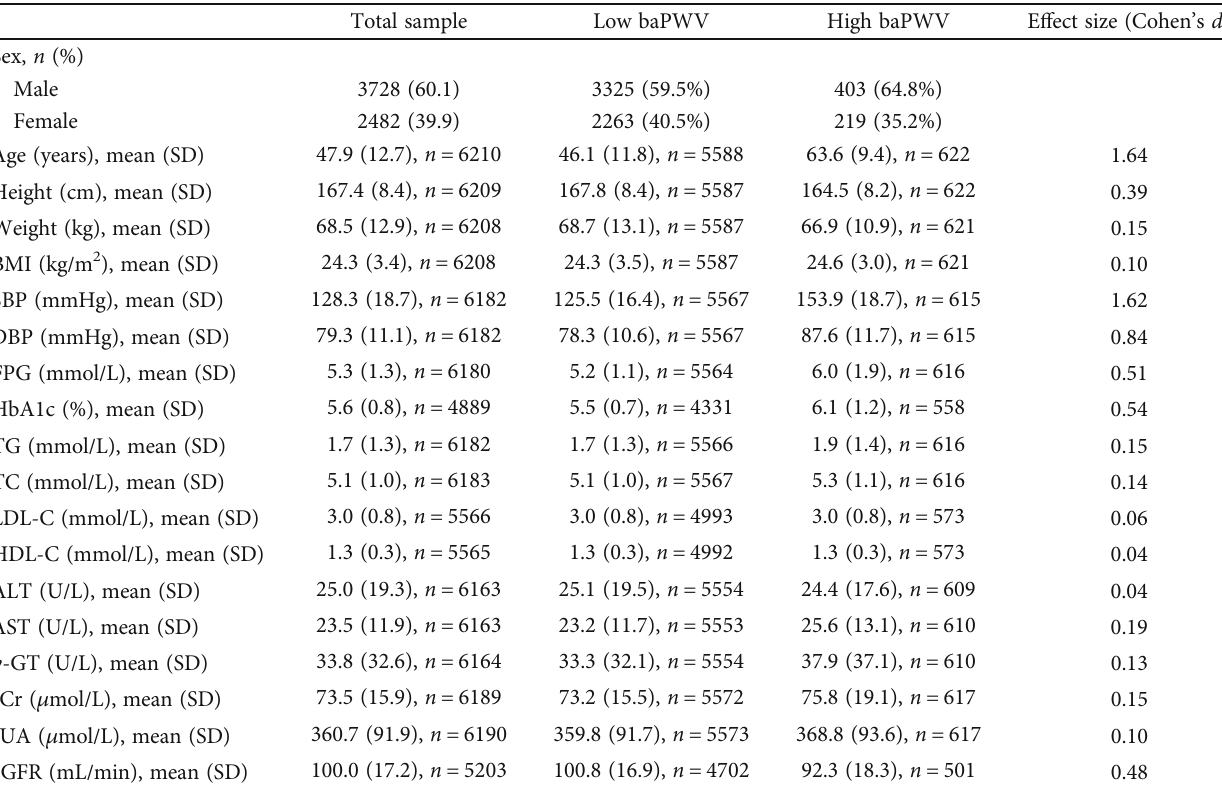
Table 1: The demographic distribution as well as the results of health examinations and blood biochemistry tests. Total